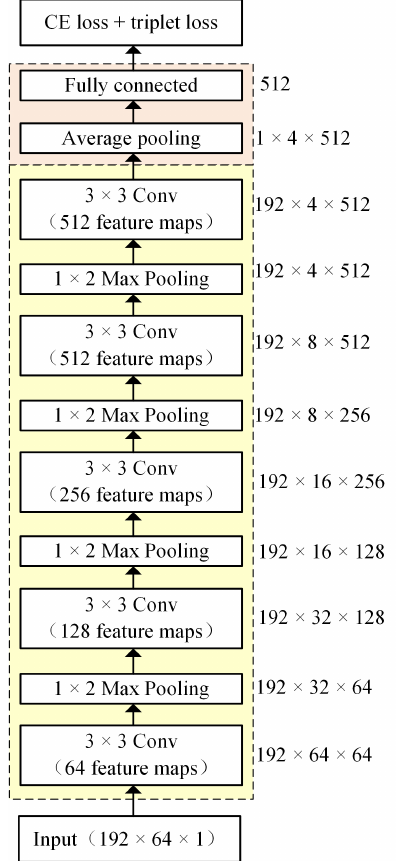
Figure 1. The architecture of convolutional neural network (CNN)-based d-vector extraction model. Cross-entropy (CE) loss and triplet loss are used in this